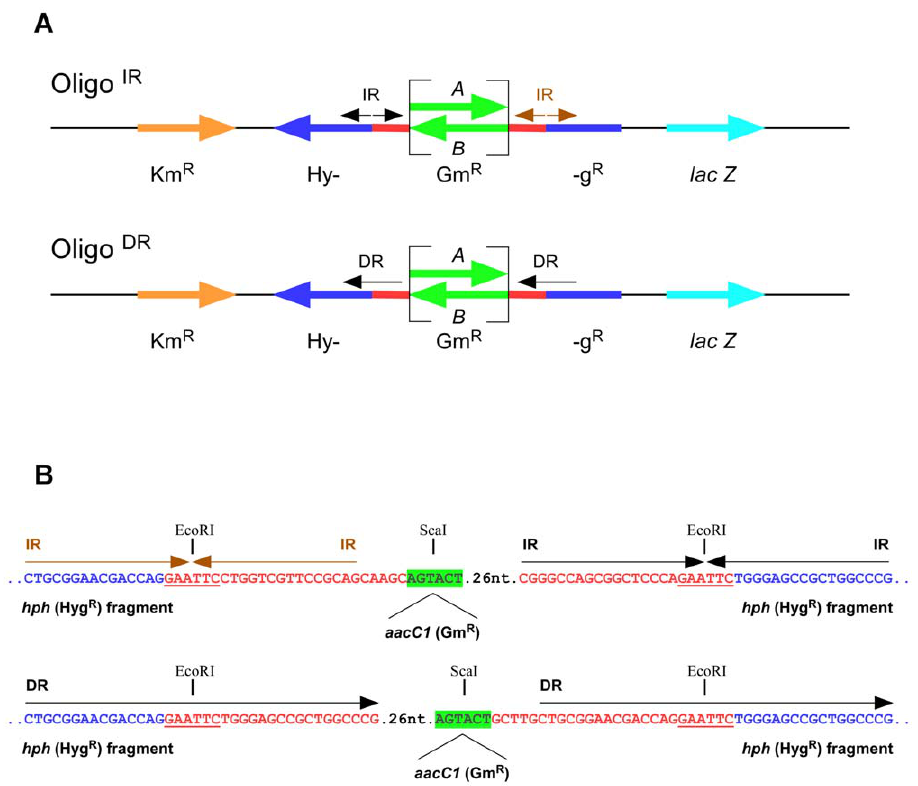
Figure 1. Key features of integration and self-replicating constructs. Panel A , Oligo IR and Oligo DR constructs. The hph (Hyg R , dark blue ) gene was interrupted by two pairs of IRs ( top ) or one pair of DRs ( bottom; black and maroon arrows over blue/red ) flanking the aacC1 (Gm R , green ) gene in both orientations (A and B). These cassettes were further flanked by the aph (Km R , orange ) gene on the left and the lac Z (blue color, light blue ) gene on the right. Panel B , detailed DNA sequence of the IRs and DRs and the relevant restriction sites (EcoRI and ScaI) used during cloning. Note that because the sequence is given in the 5 9 R 3 9 direction with respect to the hph gene, the map is opposite to that shown in Panel A.